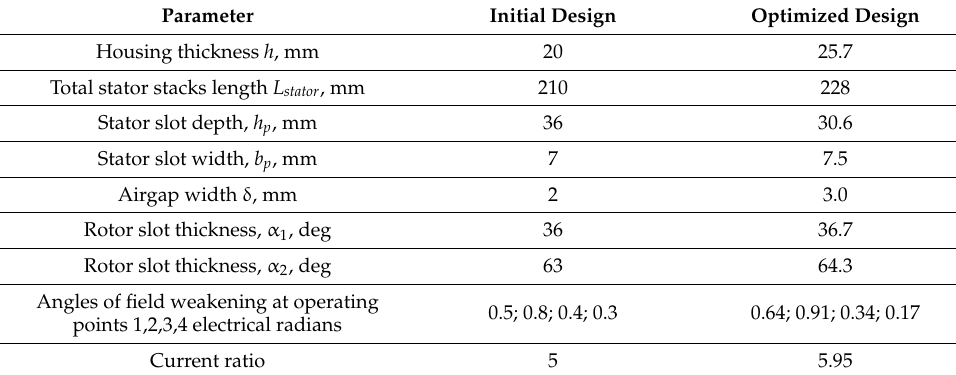
Table 3. Geometric parameters varied during the optimization.